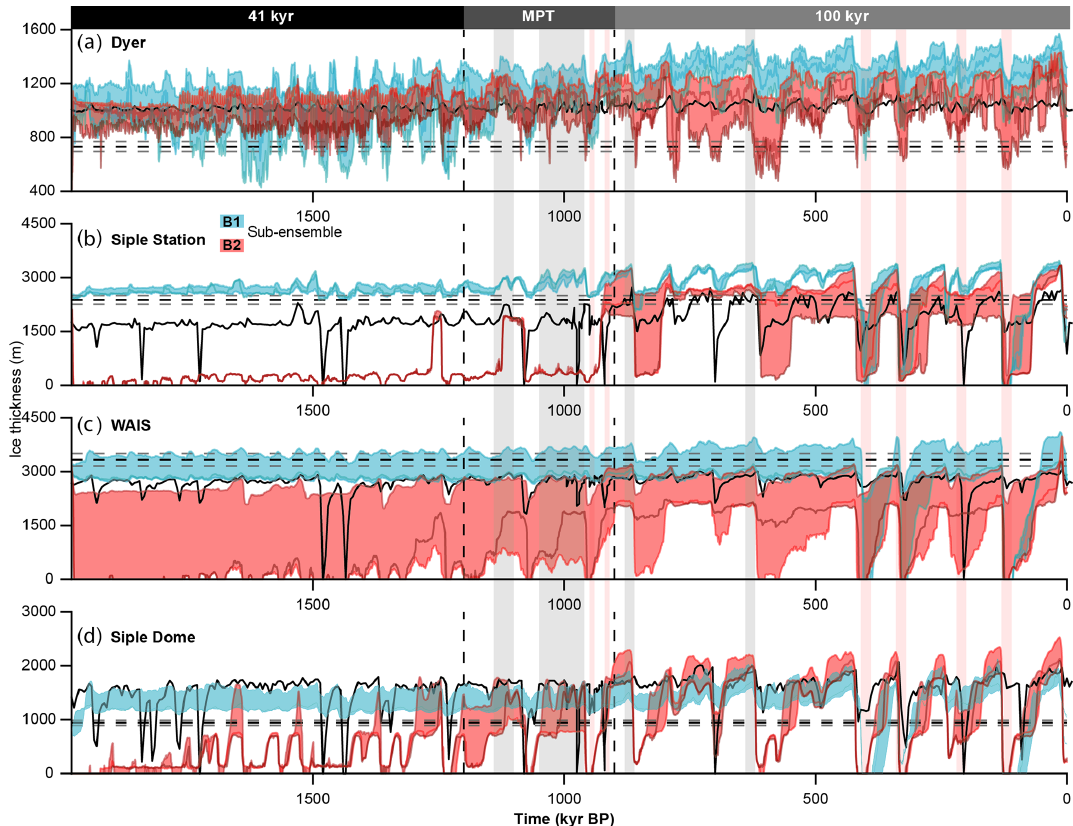
Figure 9. Ice thickness evolution during the last 2Myr as simulated in our model ensemble for the four West Antarctic ice core locations (see Fig. 1). Blue lines are from ensemble B1 (as in Fig. 6) and red lines from B2. Sampling rate is 1kyr. For comparison, the ice thickness evolution simulated in Pollard and DeConto (2009) is plotted in black (sampling rate 10kyr). The observed present-day ice thickness, derived from BEDMAP2 (Fretwell et al., 2013), is shown by the horizontal black dashed line, with 5% variation illustrated by grey dashed lines. The ice thickness simulated in Pollard and DeConto (2009) is based on a 5Myr transient simulation using BEDMAP1 (Lythe et al., 2001) as the initial ice-sheet